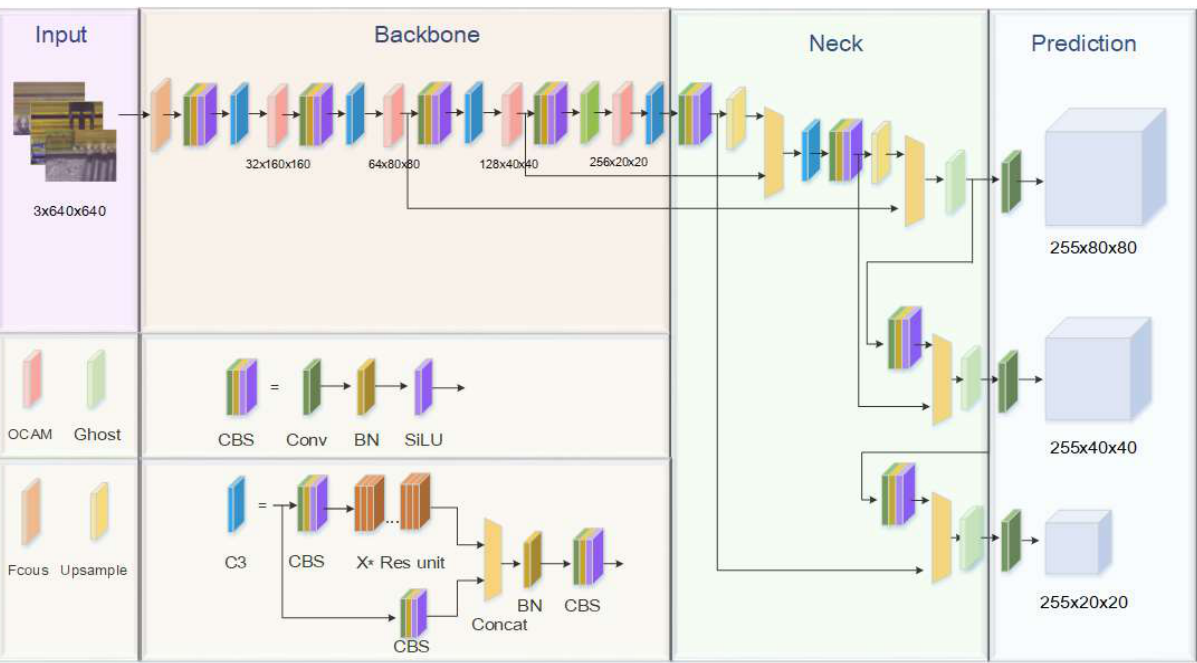
Figure 2. Proposed improved YOLOv5s network structure diagram.